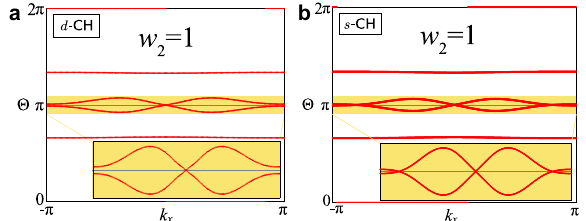
Fig. 3 The Wilson loop spectrum. The number of crossing points on Θ = π is 1 for a d -CH and 3 for b s -CH, indicating a nontrivial second SW number w 2 = 1 for both systems. The insets show zoomed-in plots of the spectrum around Θ = π